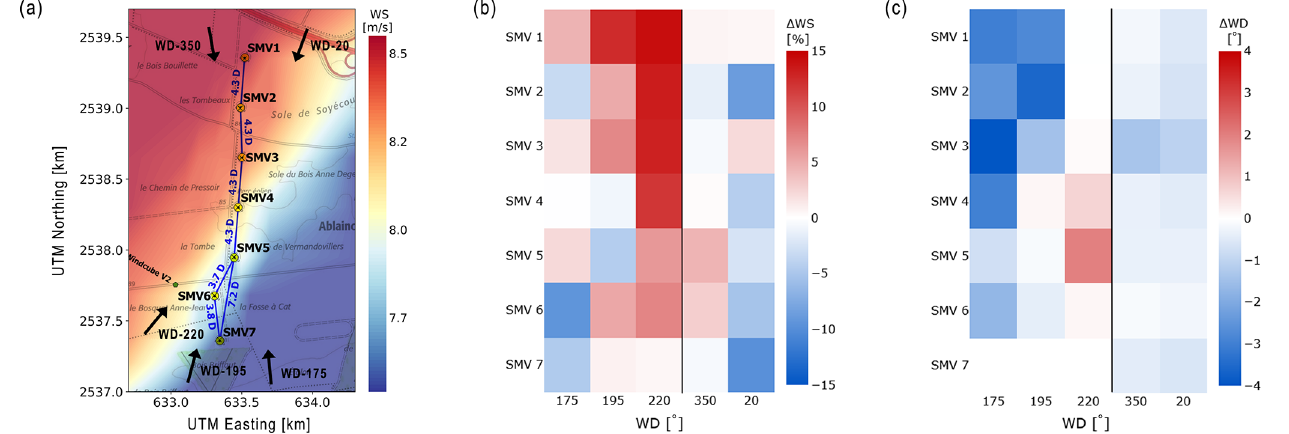
Figure 6. (a) Wind speed and direction node locations within the cluster. (b) Identified speed-up ( (cid:49) WS) nodal values. (c) Identified wind direction ( (cid:49) WD) nodal